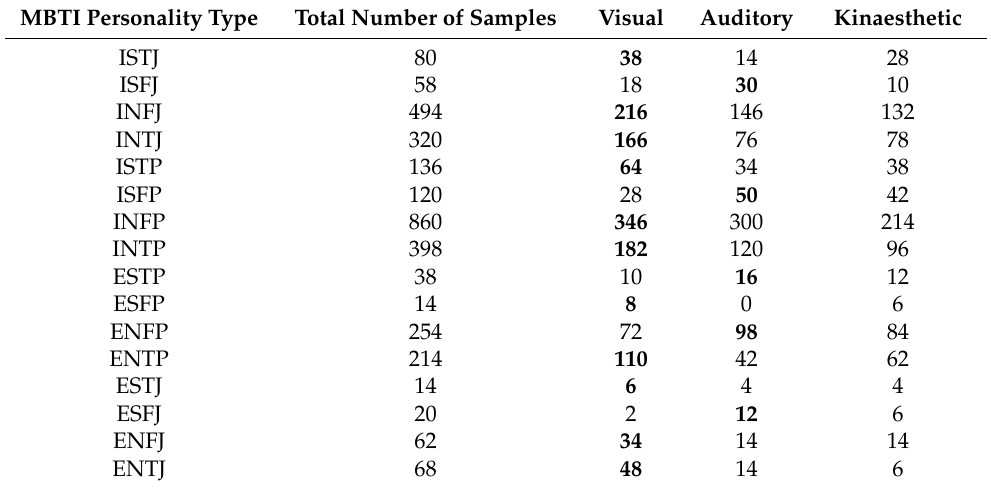
Table 4. Relationship between MBTI personality types and the preferred representational systems. MBTI Personality